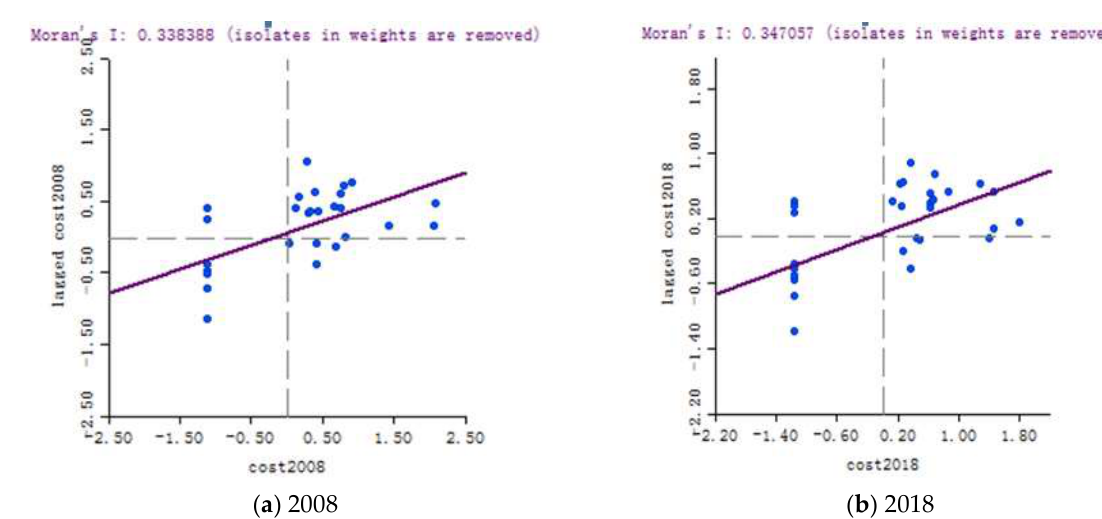
Figure 3. Moran scatter plots of corn production cost in various regions of China in 2008 and 2018.